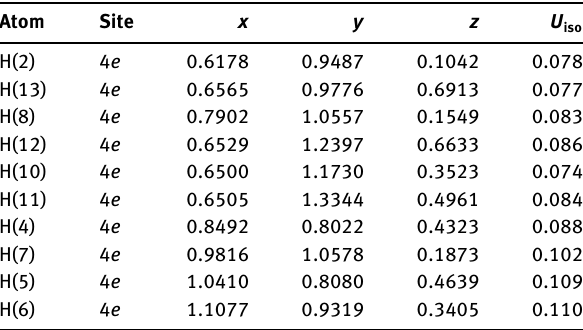
Table 2: Fractional atomic coordinates and isotropic or equivalent isotropic displacement parameters (Å 2